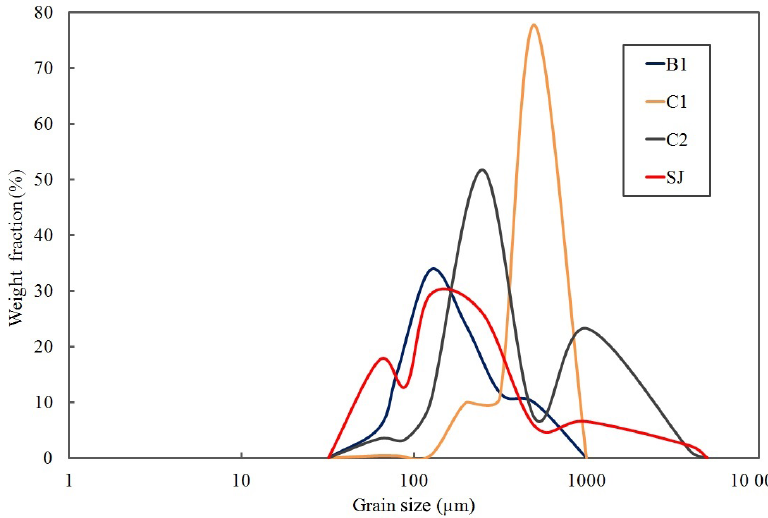
Figure 4. Grain-size analysis for samples from tephra fall collected around Tungurahua two weeks after